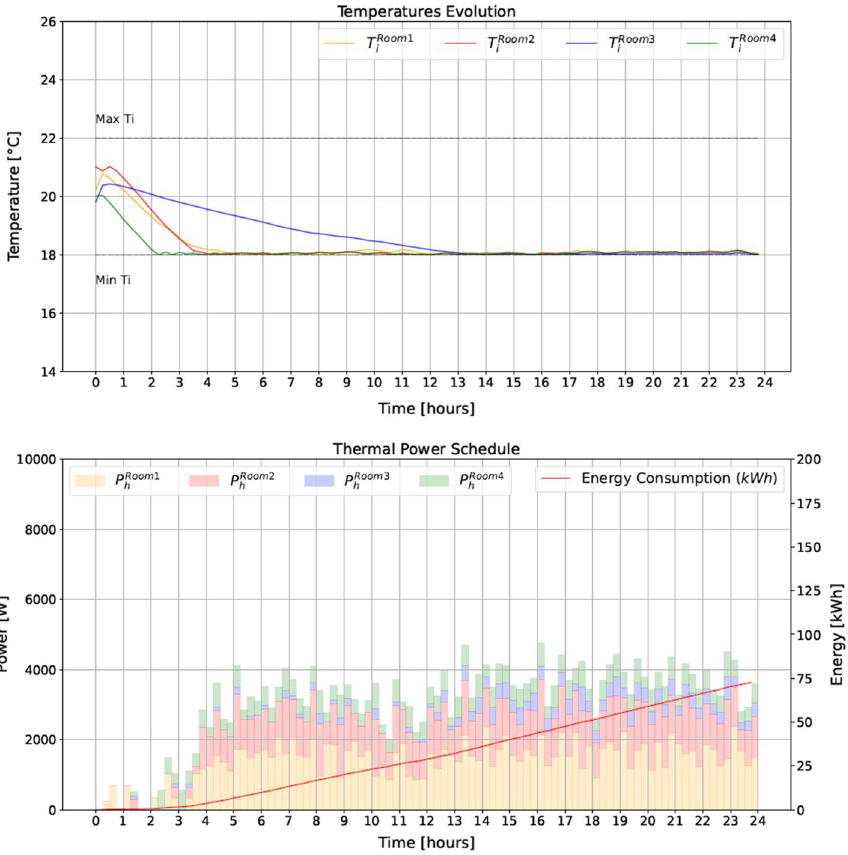
Fig. 8 The scenario of minimum energy consumption in terms of rooms’ temperature, power scheduling, and cumulative energy